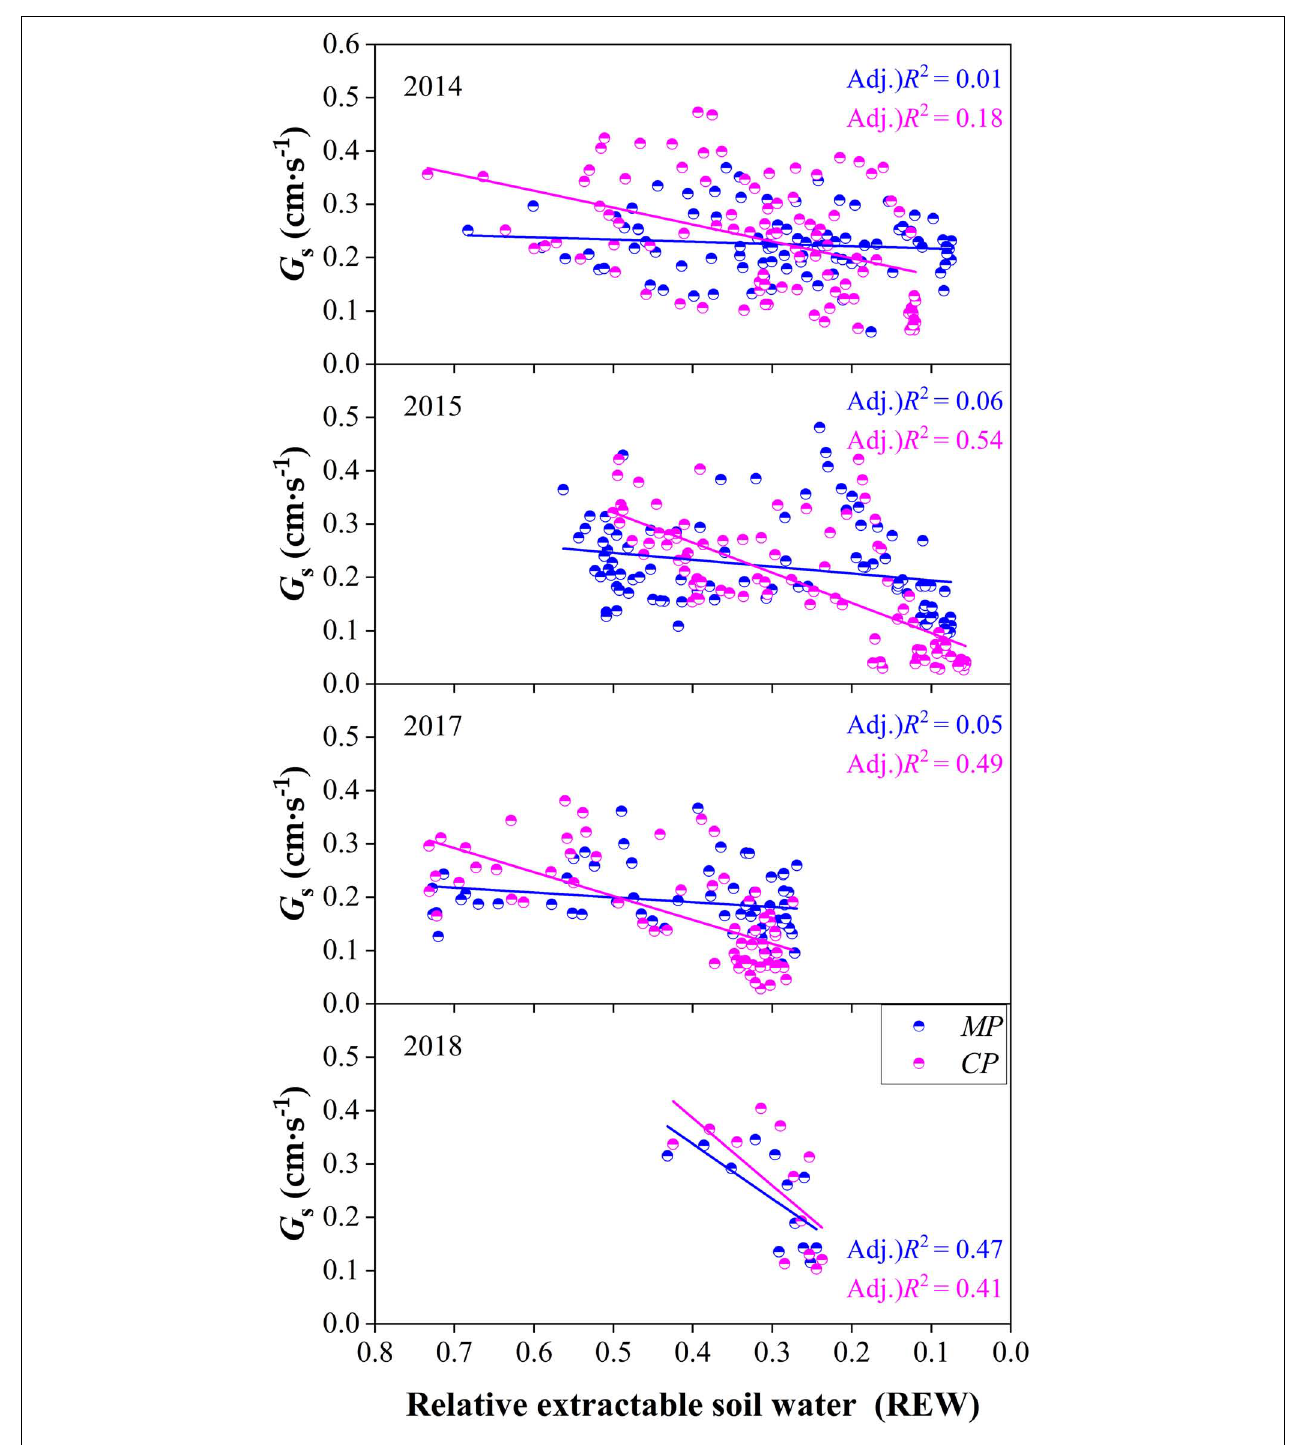
FIGURE 9 | Comparison of canopy conductance, G s varied with the level of relative extractable soil water (REW) between Chinese pine ( CP ) and Mongolian Scots pine ( MP ) in different years.